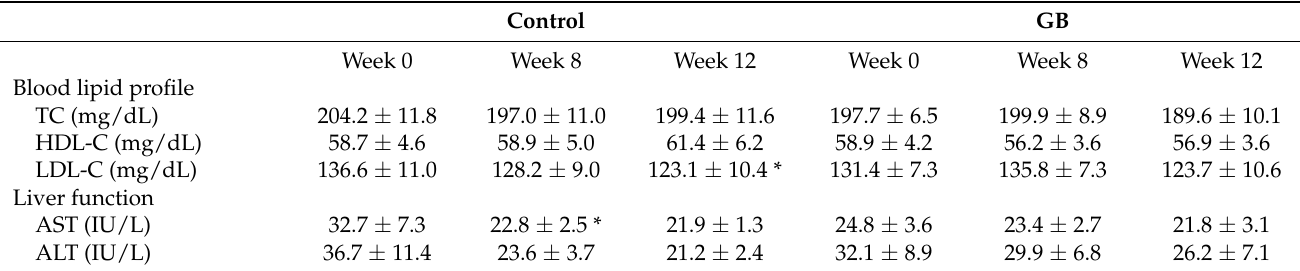
Table 6. Effects of GB on blood lipid profile and liver function 1–3